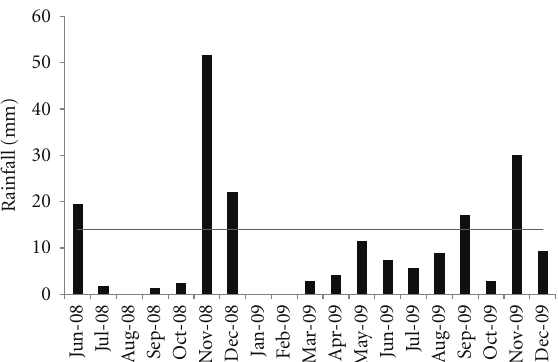
Figure 1: Rainfall recorded 6 months prior and during the study period. The line indicates the monthly